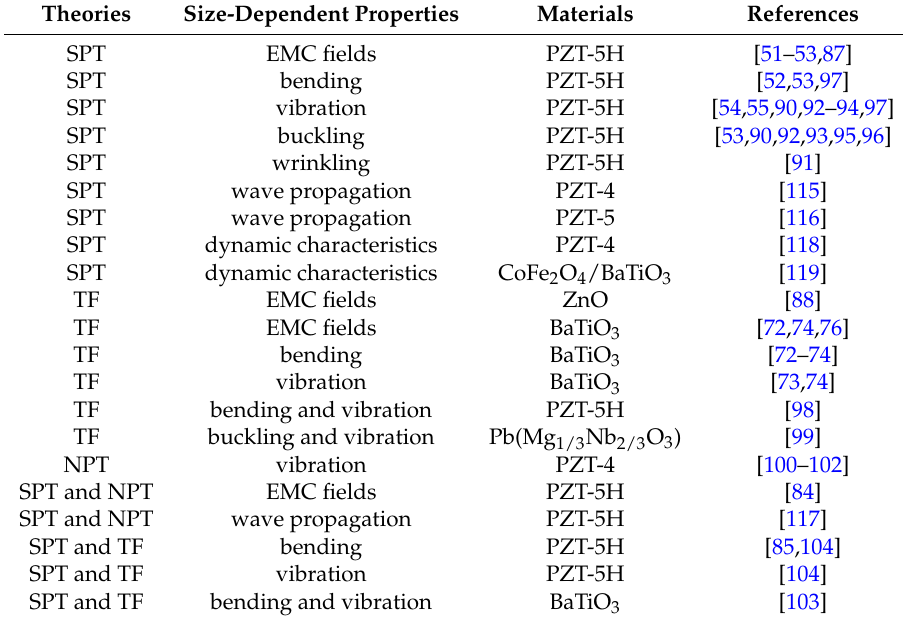
Table 1. Summary of the size-dependent mechanical and electromechanical coupling properties of piezoelectric nanomaterials (PNs) based on different theories. Acronyms: SPT